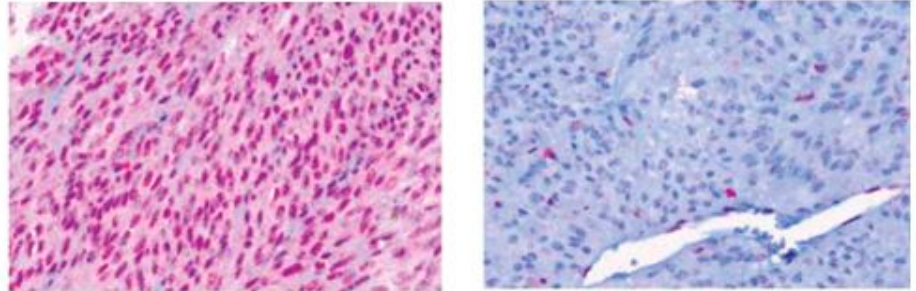
Figure 6. Microscopic overview of uveal melanoma with BAP1 expression 400x ( left ) and absence